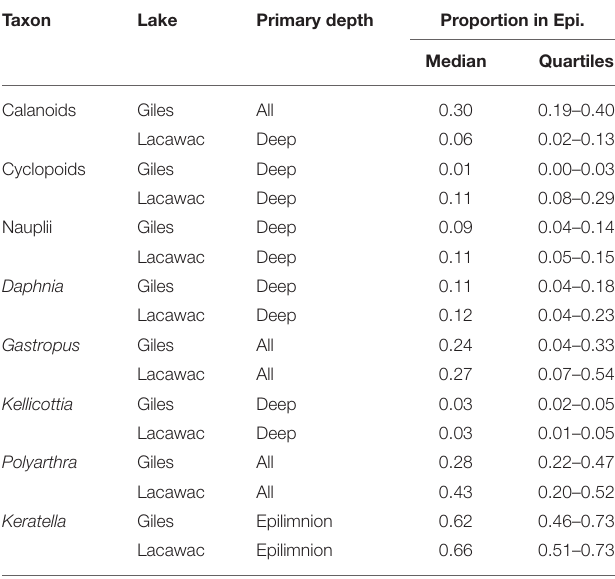
TABLE 1 | Primary depth inhabited by zooplankton estimated as the proportion of individuals of each taxon found in the epilimnion. Taxon Lake